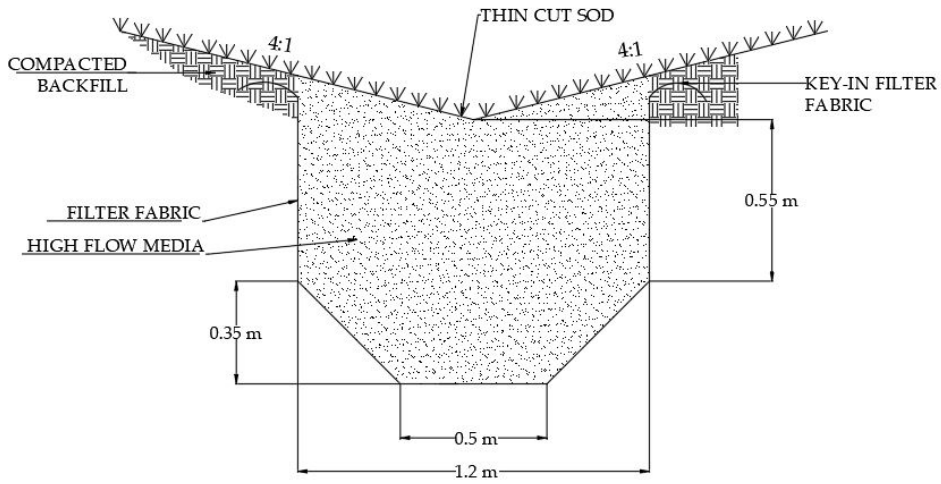
Figure 2. Horizontal cross-section of the first 23.8 m of the bioswale. Table 1. High-flow media characteristics.